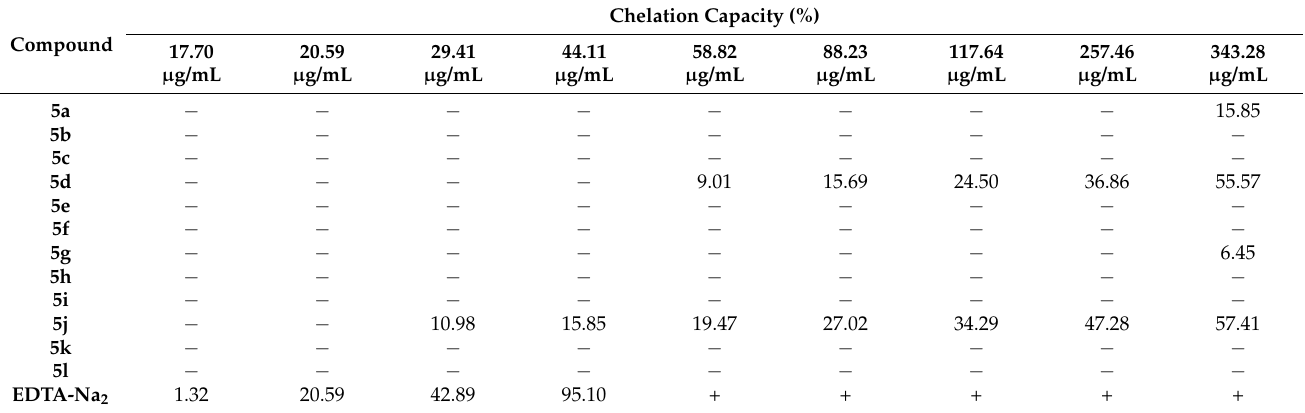
Table 5. Results of the ferrous ions chelation capacity evaluation.